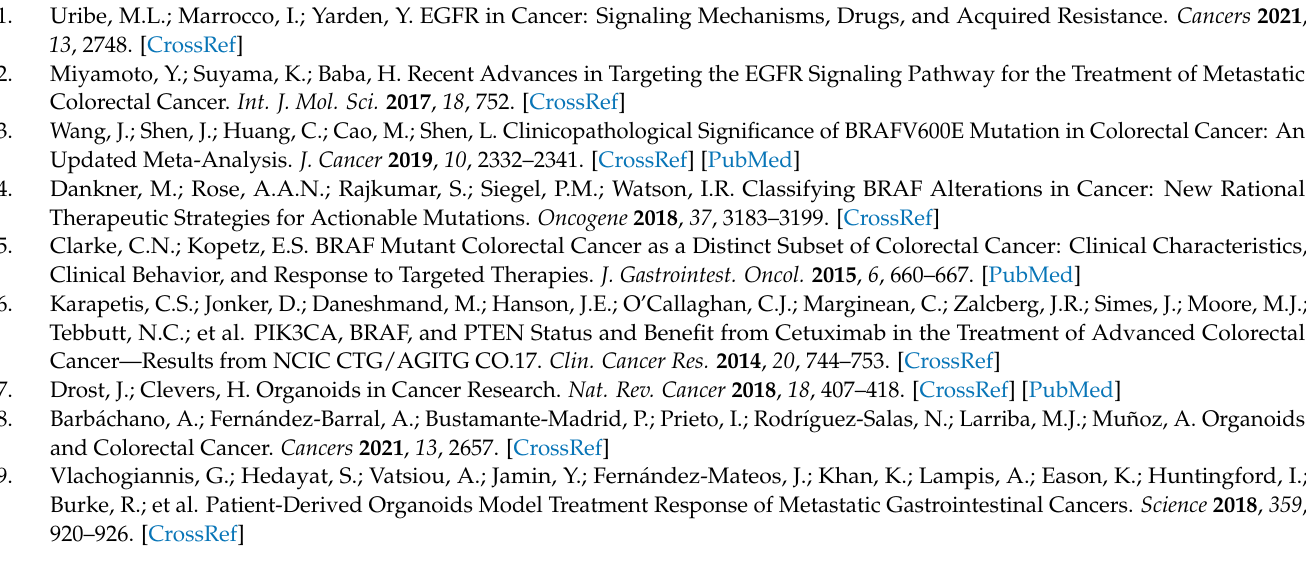
Table S3: Statistics of data reported in Figures 4 and 5